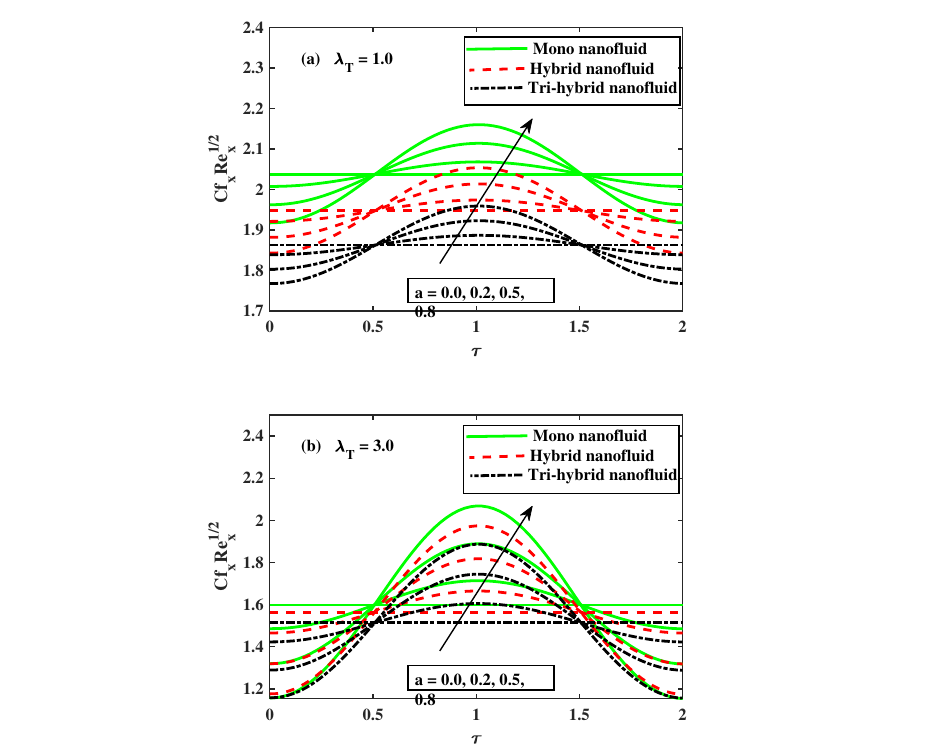
Figure 7. ( a ) Fluctuation of λ T on Cf x Re 1/2 x ; ( b ) Fluctuation of λ T on Cf x Re 1/2 x .